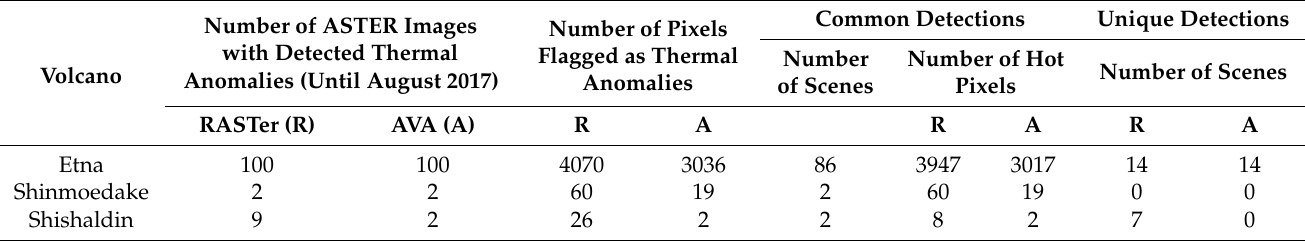
Table 2. Summary of RASTer and AVA comparison performed by analyzing ASTER TIR data of 2000–2017 over Etna (Italy), Shinmoedake (Japan) and Shishaldin (AK, USA). Number of ASTER Images with Detected Volcano